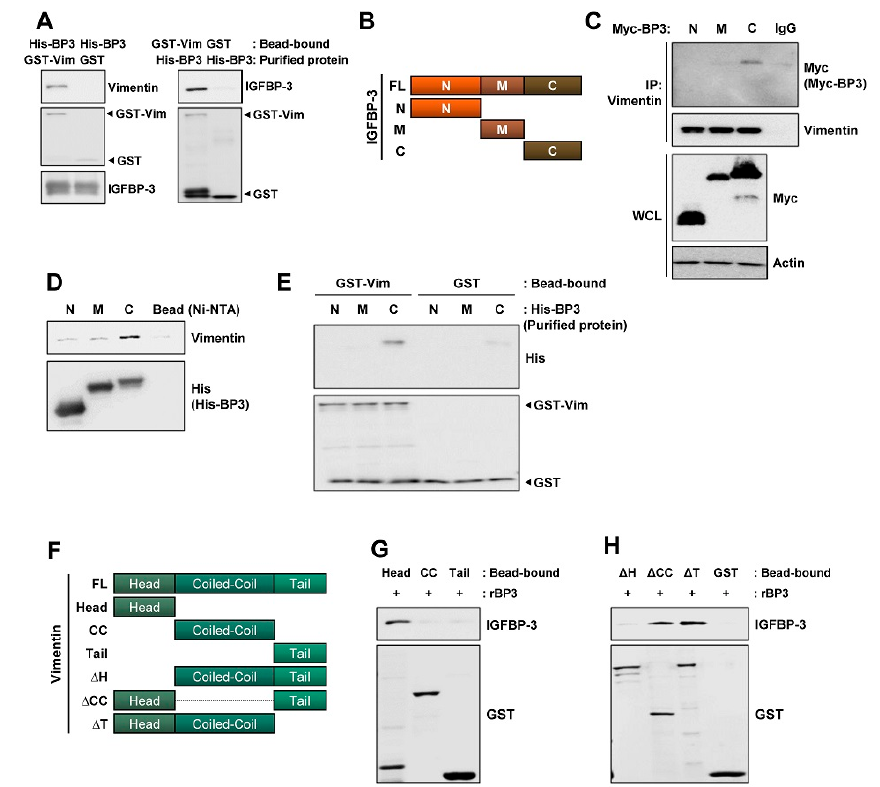
Figure 5. C-terminal domain of IGFBP-3 and the head domain of vimentin are critical for the binding of IGFBP-3 to vimentin . ( A ) Pull-down assays to determine the interaction between IGFBP-3 and vimentin. Purified and bead-bound proteins in each pull-down set were indicated. ( B ) Schematic diagram illustrating full-length and domain constructs (N: N-terminal domain; M: middle domain; C: C-terminal domain) of the IGFBP-3 protein. ( C ) HEK293T cells were transfected Myc-tagged IGFBP-3 domain constructs for 48 h. Interaction between vimentin and C domain of IGFBP-3 was determined by immunoprecipitation with the anti-vimentin antibody and subsequent Western blot (WB) analysis. Bottom . Expression of each IGFBP-3 domain was determined by WB analysis. ( D ) Pull-down assay for the interaction between N-, M-, C-terminal domain of IGFBP-3 and endogenous vimentin protein. The Ni-NTA agarose-bound His-tagged IGFBP-3 domains (N, M, and